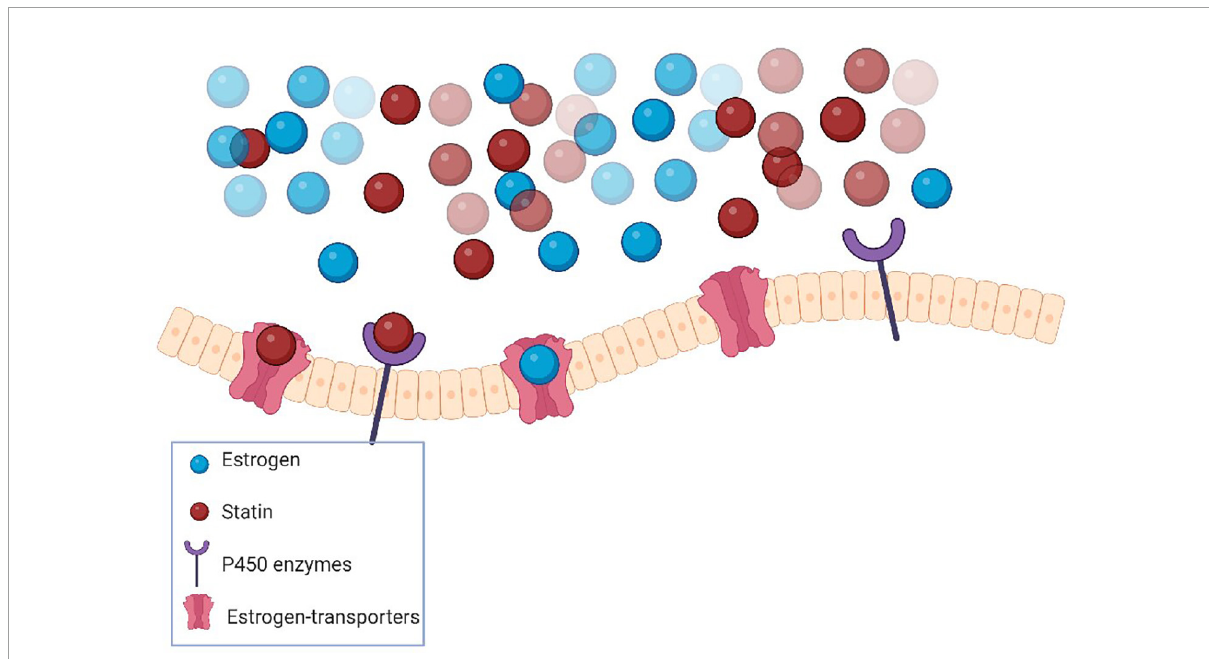
FIGURE2 Statins-estrogen hormone interactions are probable because of the common metabolic pathways in the liver with the same cytochrome P450 enzymes. Also, statins could compete with estrogens for the same transporters.